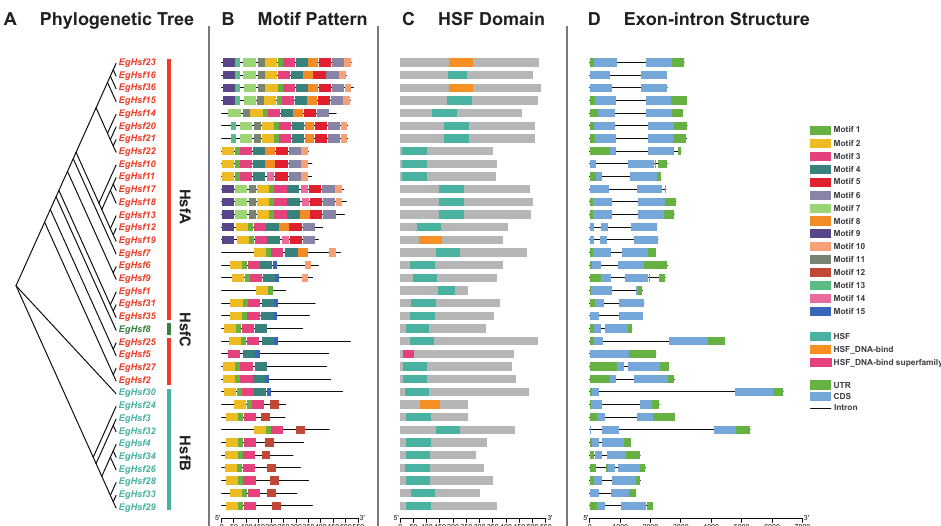
Figure 4. Structure of EgHsf gene members. ( A ) Phylogenetic relationships among EgHsf members. ( B ) Distribution of conserved motifs of the EgHSF protein. A total of 15 motifs were identified. The scale at the bottom shows the length of the protein, and the sequence identity of each conserved motif is marked on the right. ( C ) Predicted conserved structural domains of EgHSF proteins. Grey bars represent the length of each protein sequence, and conserved domains are indicated by colored boxes. ( D ) Exon–intron structure of the EgHsf genes. Yellow boxes indicate exons (CDS), black lines indicate introns and green boxes indicate 5 (cid:48) and 3 (cid:48) untranslated